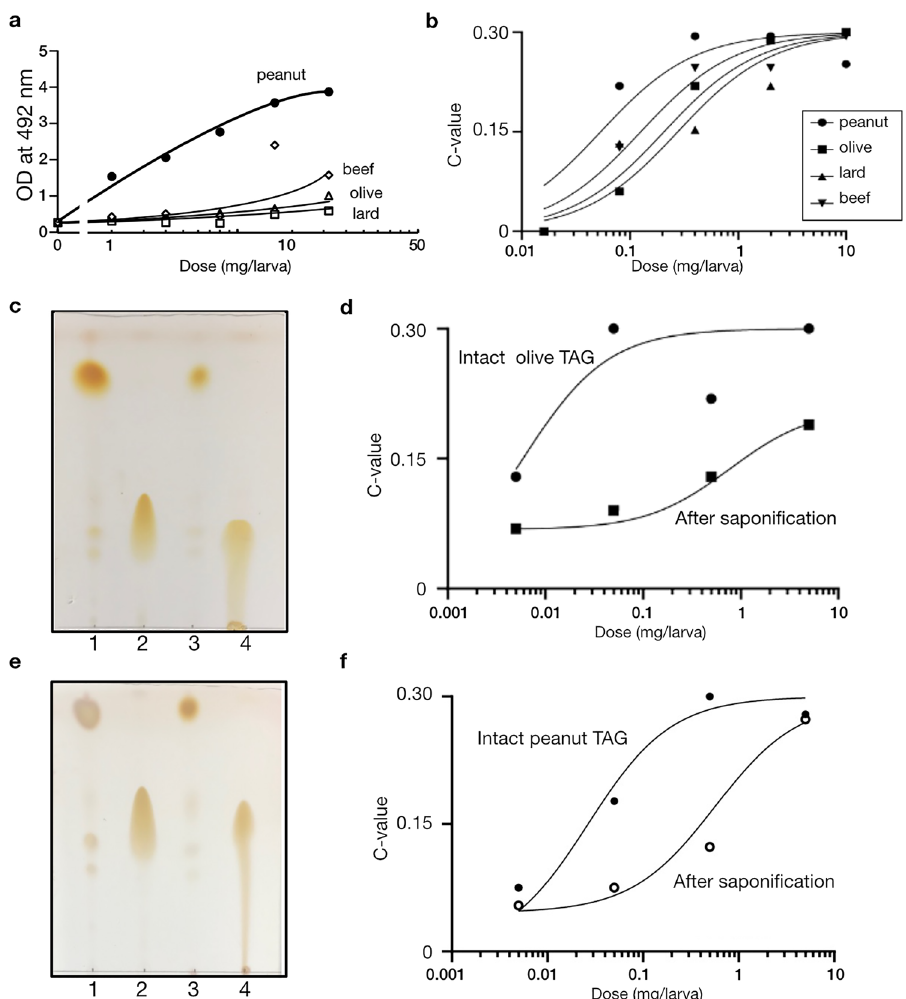
Figure 5. Comparative study of different sources of TAGs for the immunoreactivity. ( a ) The melanin inducing effect of the peanut TAGs was outstanding as compared to other (olive, beef fat and lard) TAGs. The y-axis of the top panel represents the OD value (492 nm) of silkworm hemolymph was measured 3 h after sample injection, and the x-axis represents the dose injected to the silkworm hemocoel (mg/larva). Mean values from duplicate measurements are shown in the chart. ( b ) The comparable muscle contraction effects of TAGs from different sources. The y-axis represents the contraction (C-) value, and the x-axis represents the dosage (mg/larva). Each plot represents a result from one silkworm specimen. ( c ) Olive TAG sample before and after the saponification reaction was analyzed by TLC. The samples shown in the panel are: (1) olive oil, (2) oleic acid, (3) olive oil mixed with NaOH without heating (i.e., before the reaction), (4) saponified olive oil. ( d ) The muscle contraction activity of olive oil was reduced by saponification reaction. The y-axis represents the contraction (C-) value, and the x-axis represents the dosage (mg/larva). Each plot represents a result from one silkworm specimen. ( e ) Peanut TAG sample before and after the saponification reaction was analyzed by TLC. The samples shown in the panel are: (1) olive oil, (2) oleic acid, (3) peanut oil mixed with NaOH without heating (i.e., before the reaction), (4) saponified peanut oil. ( f ) The muscle contraction activity of peanut oil was reduced by saponification reaction. The y-axis represents the contraction (C-) value, and the x-axis represents the dosage (mg/larva). Each plot represents a result from one silkworm